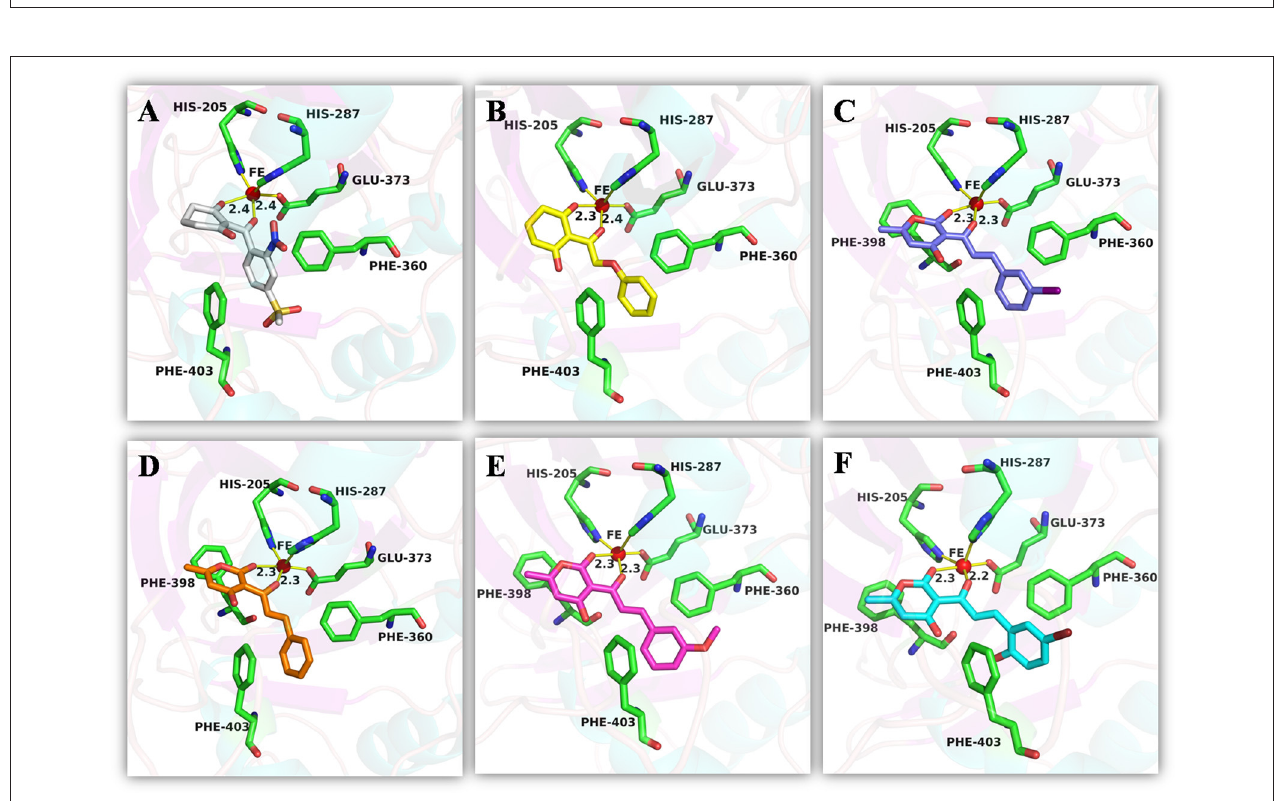
FIGURE 10 | The receptor-ligand interaction of (A) control 1 (mesotrione), (B) control 2 (2-(Aryloxyacetyl) cyclohexane-1,3-diones), (C) compound 3885, (D) compound 3881, (E) compound 3882, and (F) compound 4293 with the HPPD active site.